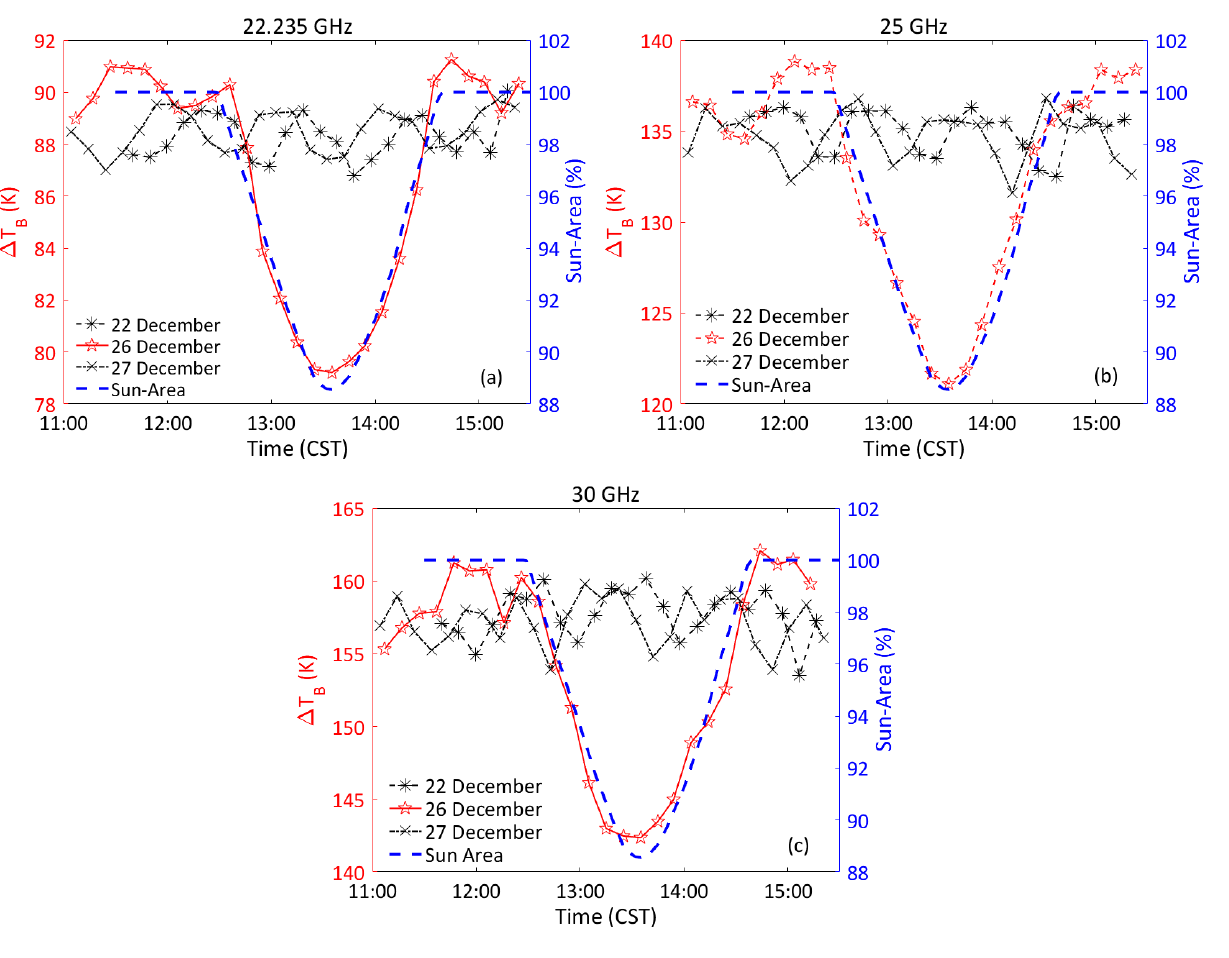
Figure 6. The variation of the T B increment (left axis) during the solar eclipse on 26 December 2019 (red solid curve with ☆ marks) as compared with that before and after the solar eclipse on 22 December and 27 December (black curve with other marks). All times were local times (CST). The blue dash line represents the percentage of the unshaded solar disk area (right axis). ( a ) 22.235 GHz; ( b ) 25.0 GHz; ( c ) 30.0 GHz.